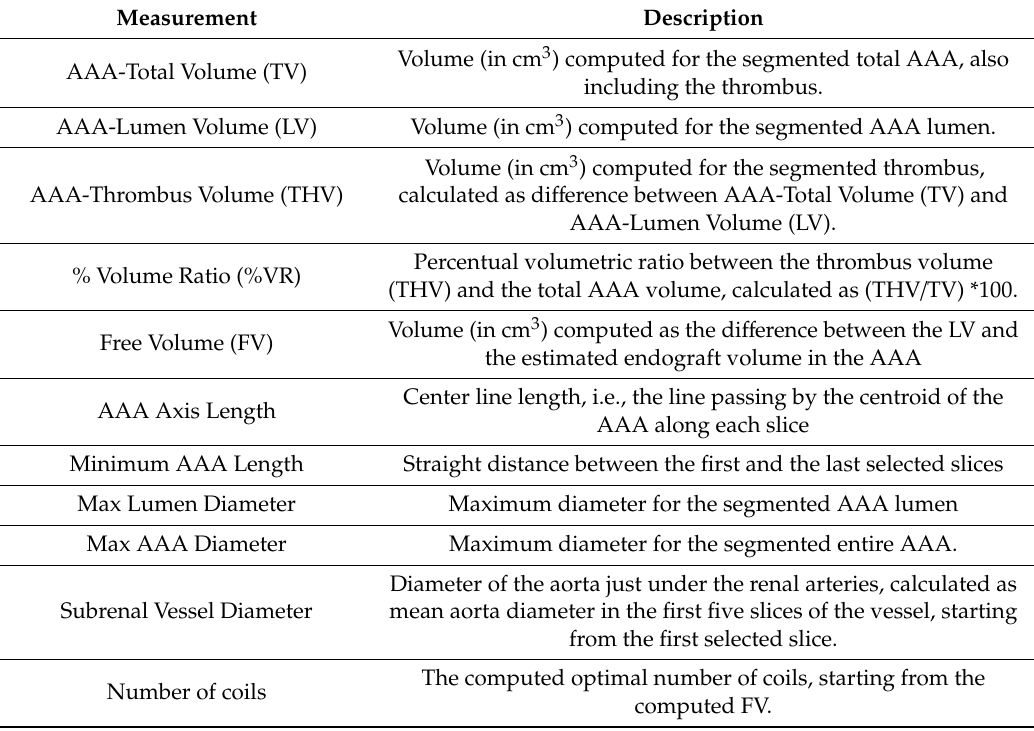
Table 1. Output measurements provided by the EVAR-eaSE software. AAA = abdominal aortic